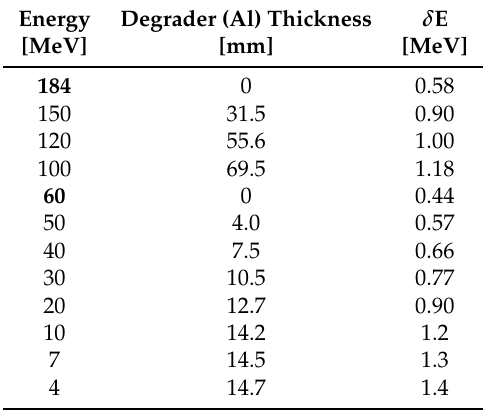
Figure 8. SEU and MBU cross section plots together with the Weibull fit function. Table 6. Proton energy deviation δ E at the DUT